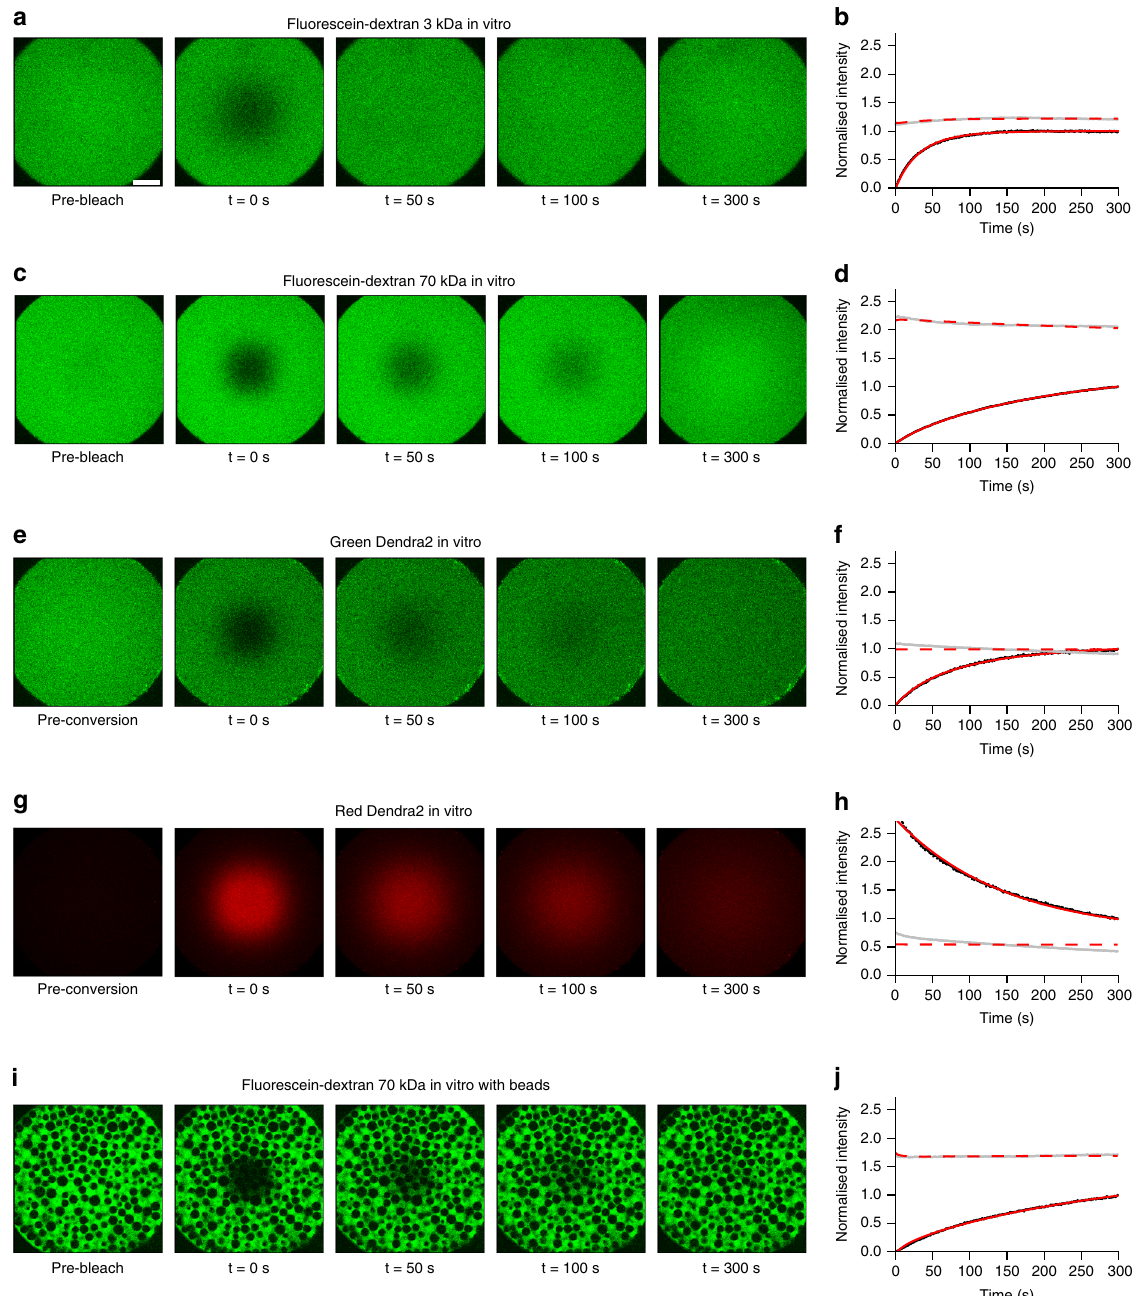
Fig. 4 Examples of in vitro FRAP and iFRAP experiments and the resulting fi ts to measure free diffusion. a , c , e , g , i In vitro FRAP and iFRAP experiment images and b , d , f , h , j fi ts with PyFRAP. Black and grey dots represent data points of bleached and slice ROI, respectively. Red solid and dashed lines show the respective fi ts. a – d FRAP experiments with 3 and 70 kDa fl uorescent dextrans (see Supplementary Fig. 5 for the full data set with fl uorescent dextrans between 3 and 500 kDa). e – h iFRAP experiment with photoconverted Dendra2 protein showing data for the green ( e , f ) and the red ( g , h ) channel. i , j FRAP experiment with 70 kDa fl uorescent dextran in the presence of polyacrylamide beads. Recovery curves were normalised between 0 (intensity in the bleached ROI at the fi rst post-bleach time point) and 1 (intensity in the bleached ROI at the last post-bleach time point) to allow comparison across data sets. The length of the white scale bar in a represents 100 μ m, and all images were acquired with the same magni fi